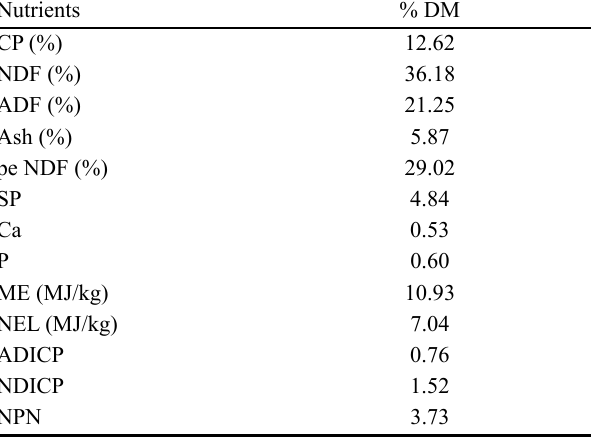
Table 2. Chemical composition of the basal diet (DM basis)